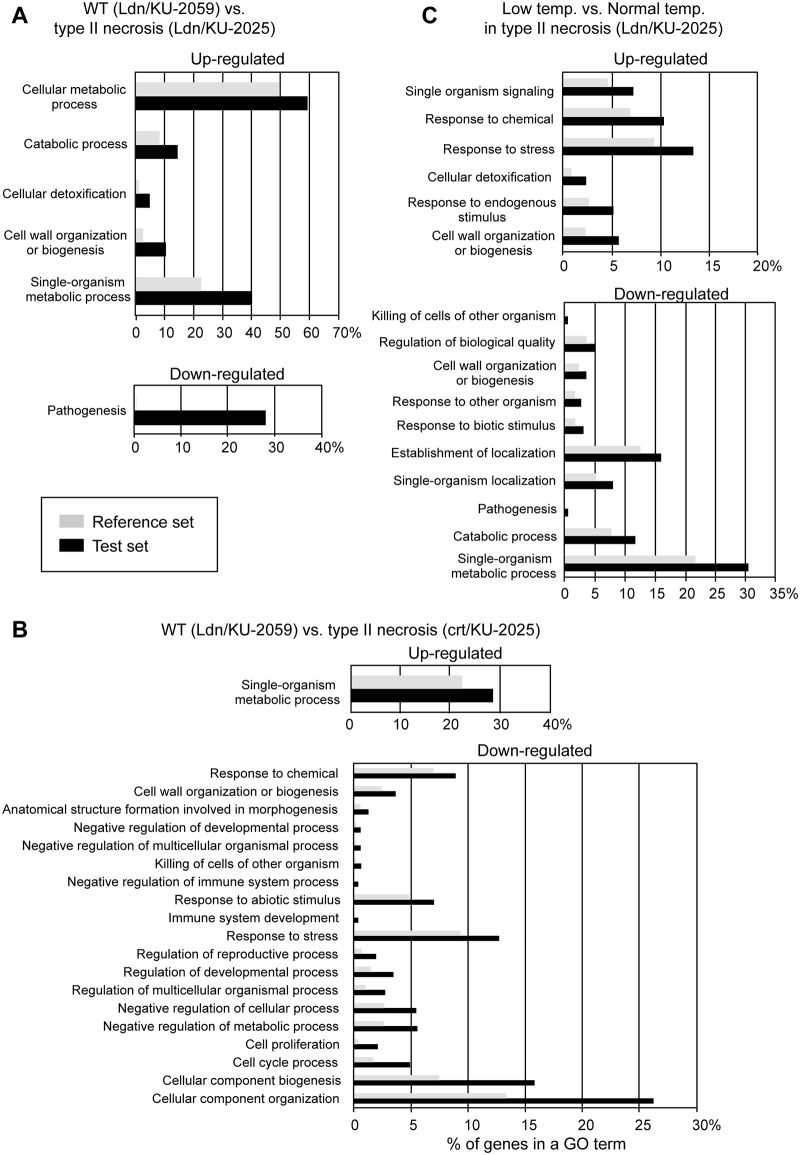
GO terms enriched among differentially expressed genes.Black bars indicate percentages of differentially encountered probes by microarray analysis (test set), and gray bars represent percentages of probes on the used array (reference set). (A, B) Comparison of transcriptomes between type II necrosis and WT synthetic wheat lines. Up- and down-regulated genes in the type II necrosis line Ldn/KU-2025 (A) and the type II necrosis line crt/KU-2025 (B) relative to the WT line (Ldn/KU-2059) were categorized into some biological groups. (C) Comparison of transcriptomes between normal temperature and LT in type II necrosis. Up- and down-regulated genes in the type II necrosis line Ldn/KU-2025 under LT relative to the necrosis line at normal temperature were categorized into some biological groups. The GO term enrichment analysis was performed using Fisher’s exact test with FDR < 0.05, the differentially encountered probes were categorized into biological processes (level 3).